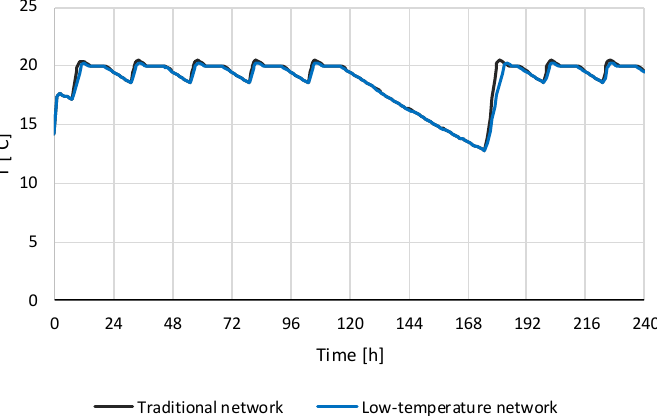
Figure 14. Renovated building – Internal temperature [°C], for traditional (black) and low-temperature (blue) network, along the simulation time [h].